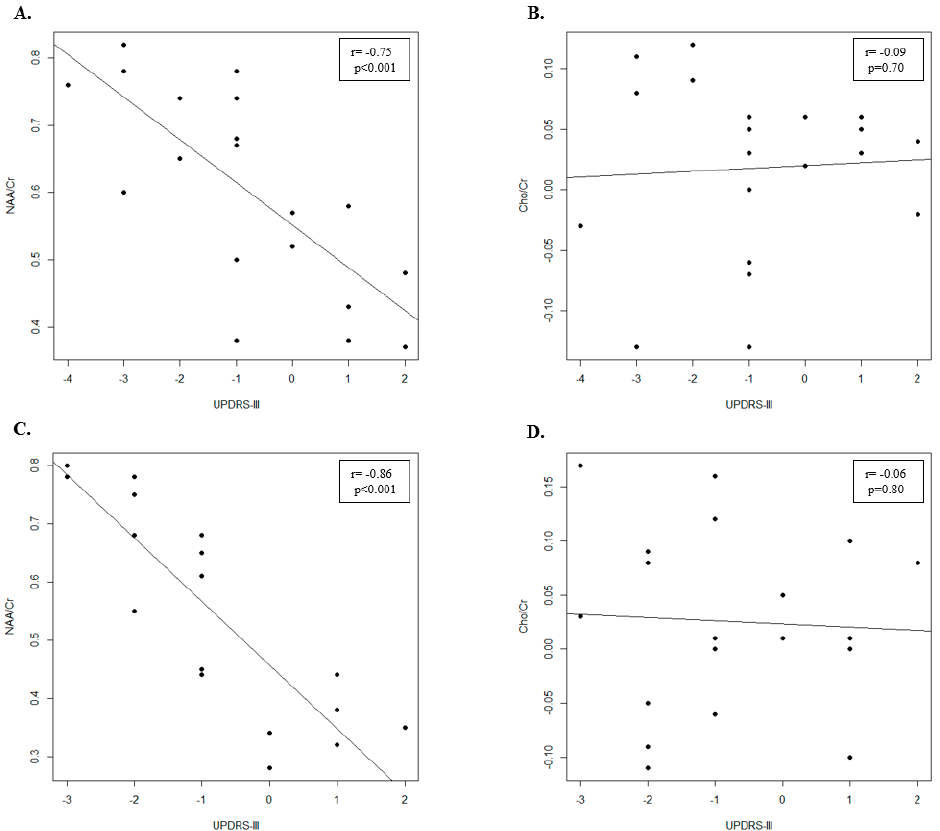
Figure 2. Scatter plot of UPDRS-III and the metabolite ratios after 12 months of therapy in PD pa- tients. ( A ) Scatter plot of UPDRS-III and NAA/Cr metabolite ratio in Rasagiline treatment group. ( B ) Scatter plot of UPDRS-III and Cho/Cr metabolite ratio in Rasagiline treatment group. ( C ) Scatter plot of UPDRS-III and NAA/Cr metabolite ratio in Selegiline treatment group. ( D ) Scatter plot of UPDRS-III and Cho/Cr metabolite ratio in Selegiline treatment group.